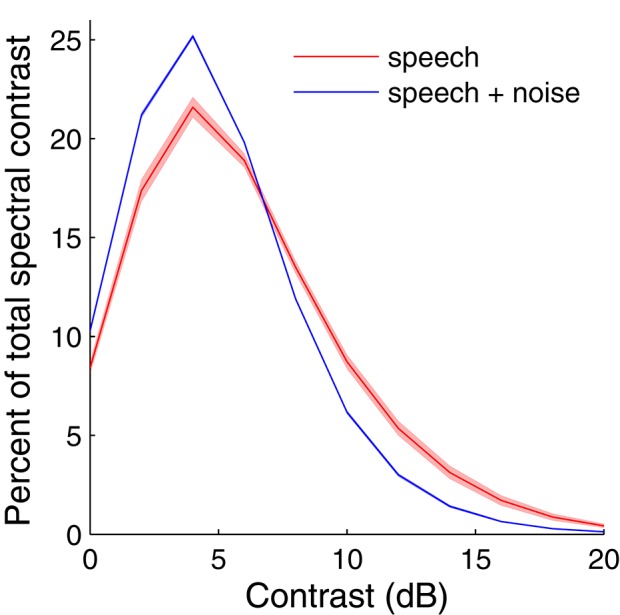
Overlay of contrast distributions as calculated by the signal processing array for 10 sentences. The overall spectral contrast distribution of a speech utterance indicates that most of the contrast values fall into the range of 4–8 dB. When the same speech utterance was corrupted with white, Gaussian noise at 5 dB SNR, the contrast distribution shifted to lower contrast values. Curves represent the mean across 10 sentences in the HINT database and the shading represents the mean ± standard deviation at each contrast value. The curves demonstrate that intermediate contrast values are common in both clean and noisy speech. Furthermore, there is little variability in contrast across sentences in the HINT database.